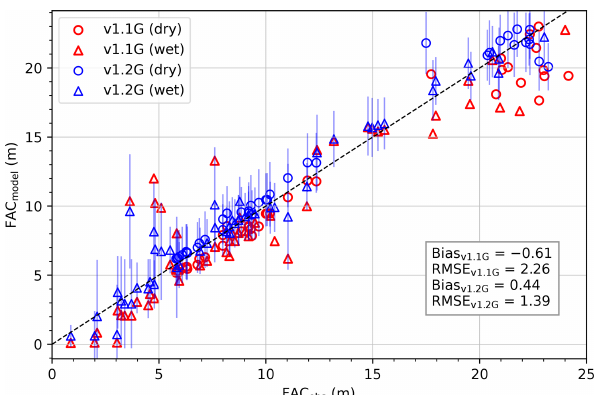
Figure 5. Modelled vs. observed firn air content in metres. Dry lo- cations are indicated with circles, whereas wet locations are indi- cated with triangles. A location is labelled as dry if it experiences 5% less melt than accumulation during the spin-up period. The blue lines indicate the uncertainty in the v1.2G